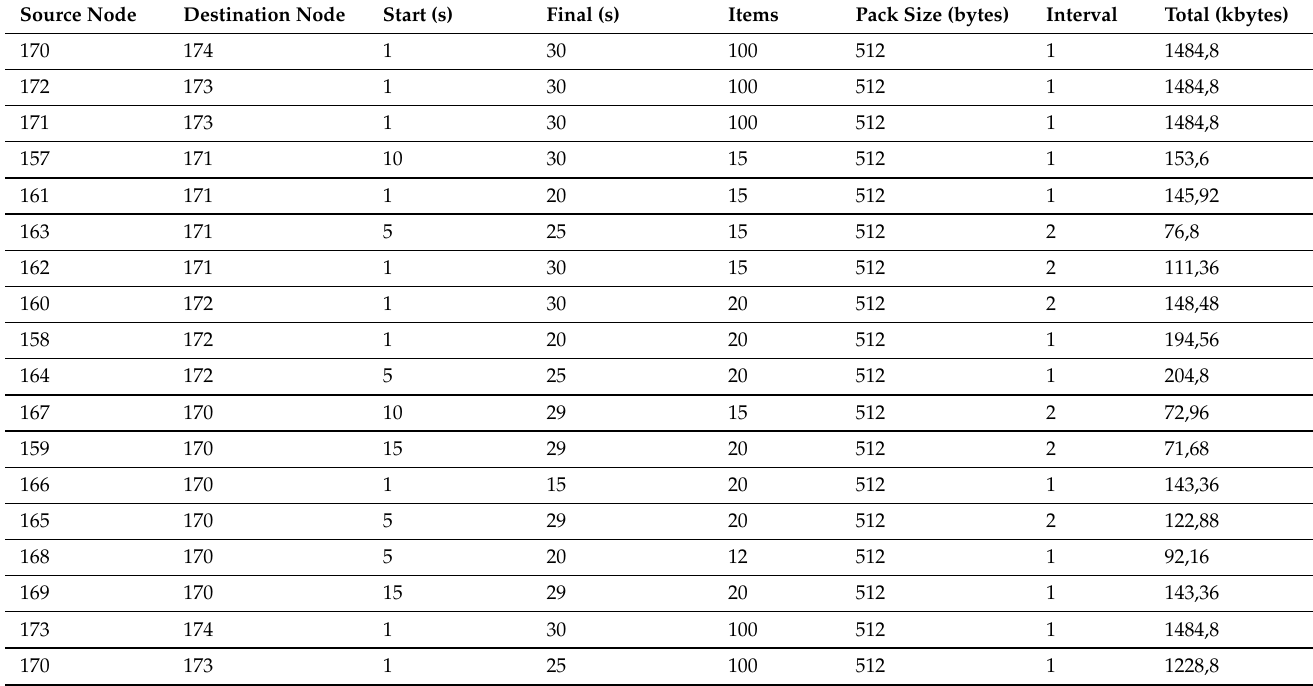
Table 5. Constant bit rate between nodes—WiFi simulation.